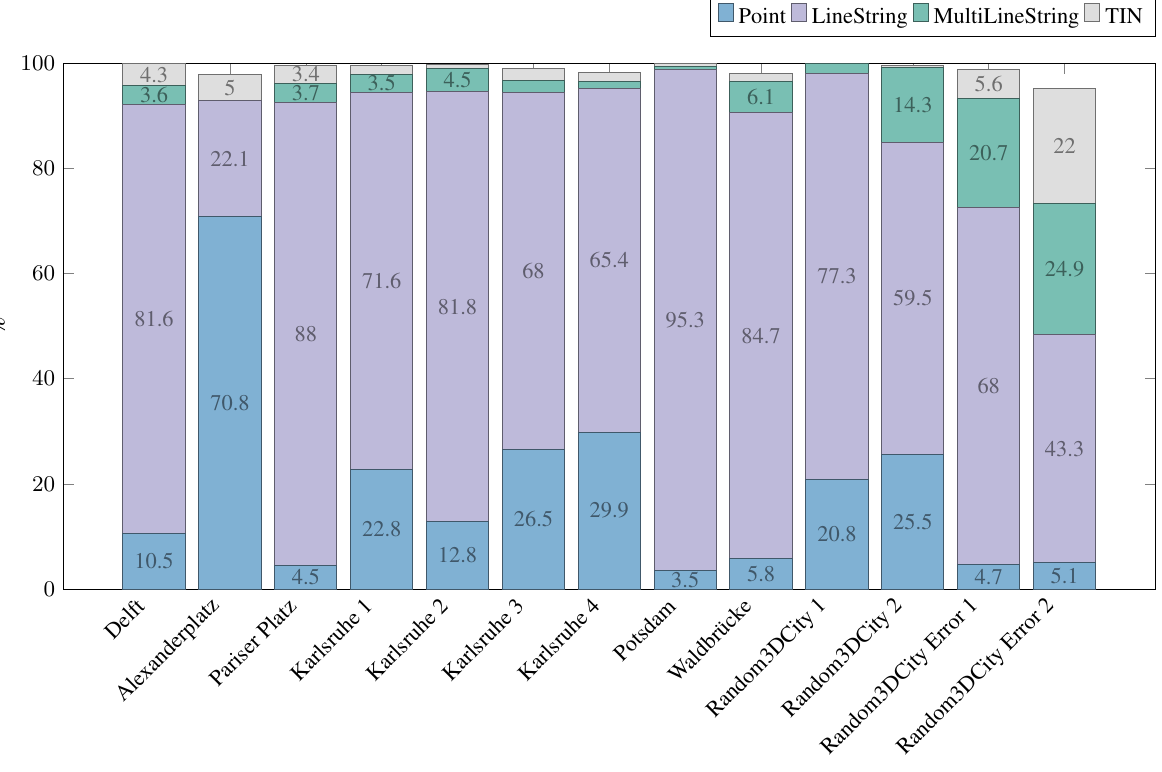
Figure 4. Proportions of the most frequent non-empty polygon intersection types